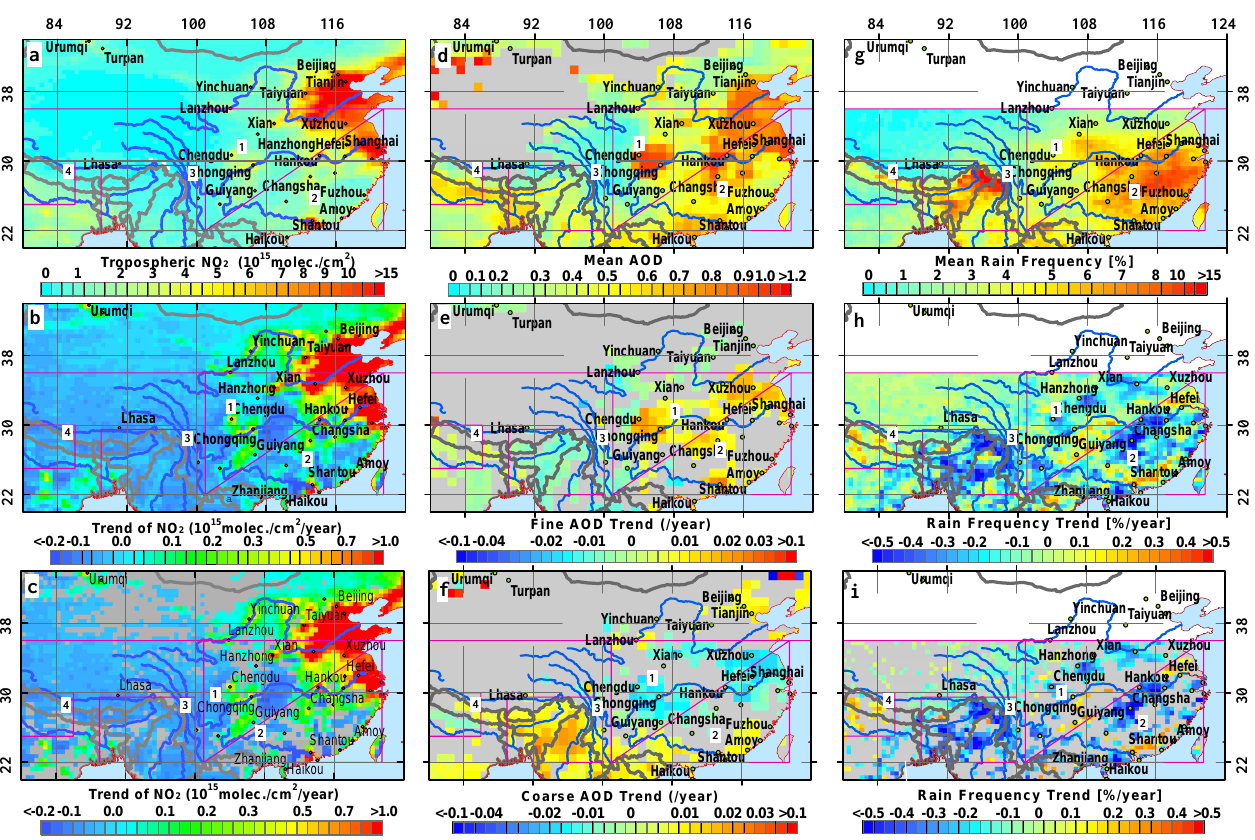
Fig. 3. Spatial distributions in spring during 1998–2009: (a) mean tropospheric NO 2 column density, (b) tropospheric NO 2 column density annual trend, (c) tropospheric NO 2 column density annual trend with significant level above 95%, (d) MODIS mean total Aerosol Optical Depth (AOD), (e) MODIS fine mode AOD annual trend, (f) MODIS coarse mode AOD annual trend, (g) mean TRMM PR rain frequency, (h) TRMM PR rain frequency annual trend, and (i) TRMM PR rain frequency annual trend with significant level above